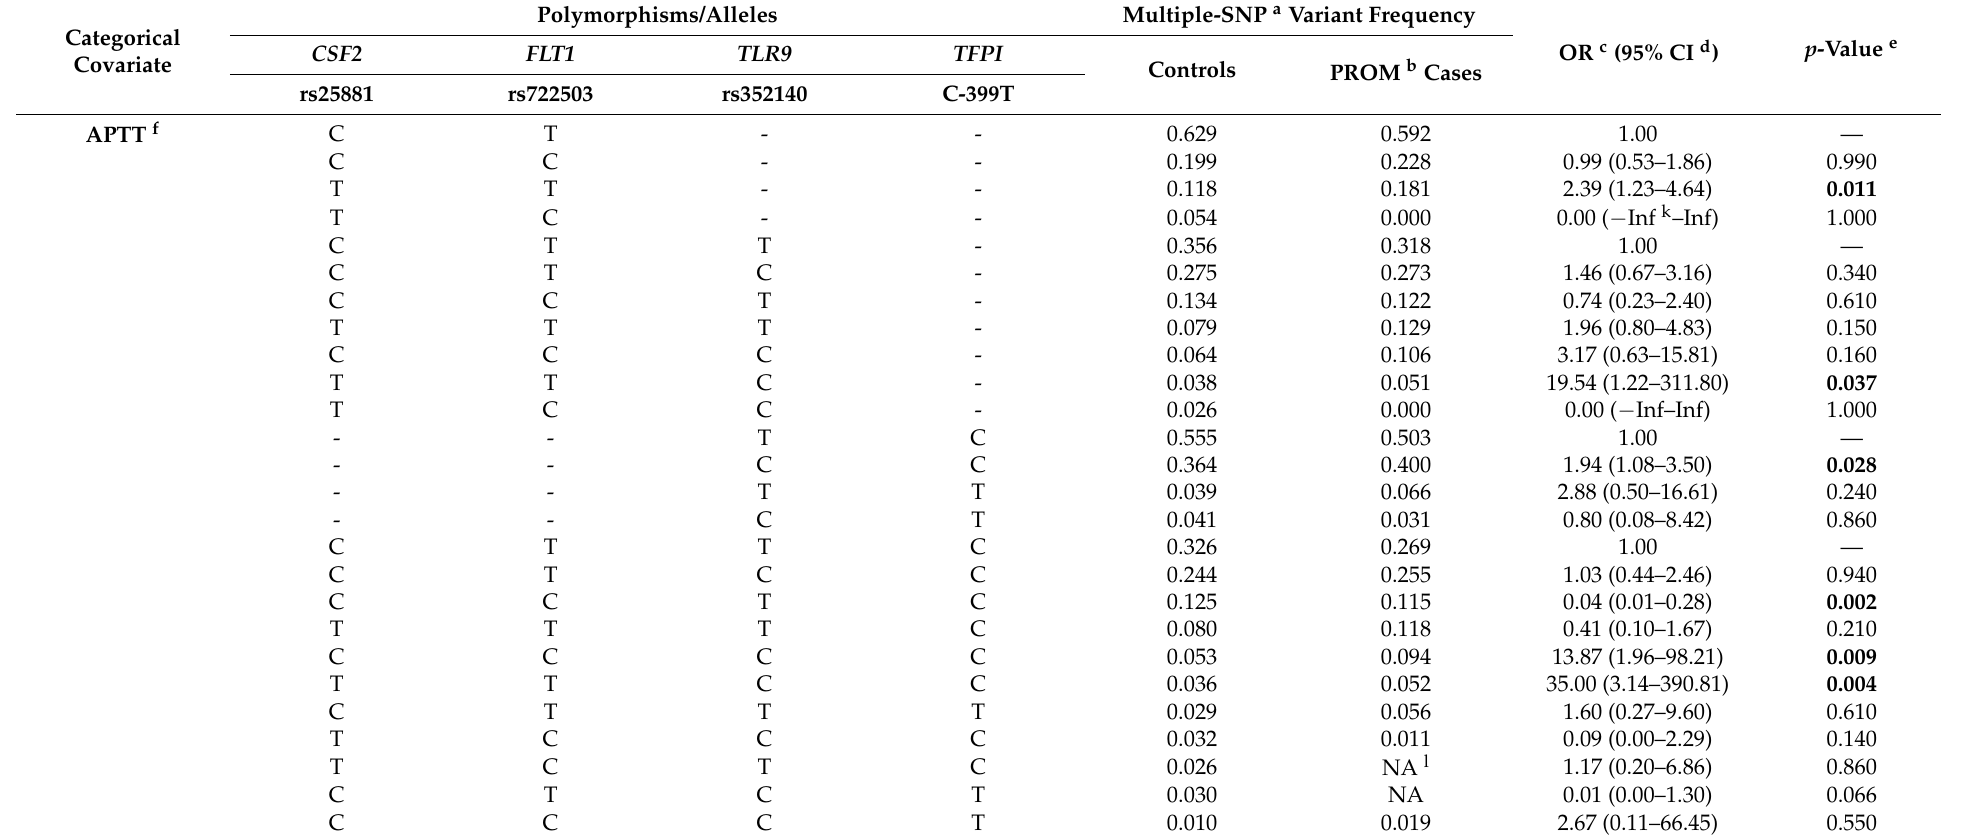
Table 3. Association of multiple-SNP variants for CSF2 , FLT1 , TLR9 and TFPI polymorphisms with PROM after correction by APTT and PLT